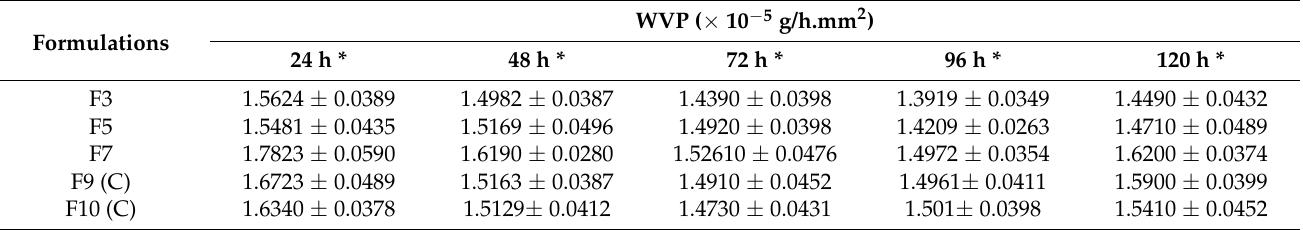
Table 4. Water vapor permeability (WVP) as a function of time (h) of selected film formulations composed of polyvinyl alcohol (PVA), polyvinylpyrrolidone (PVP), ethylcellulose (EC) and tramadol (10%, w/w).